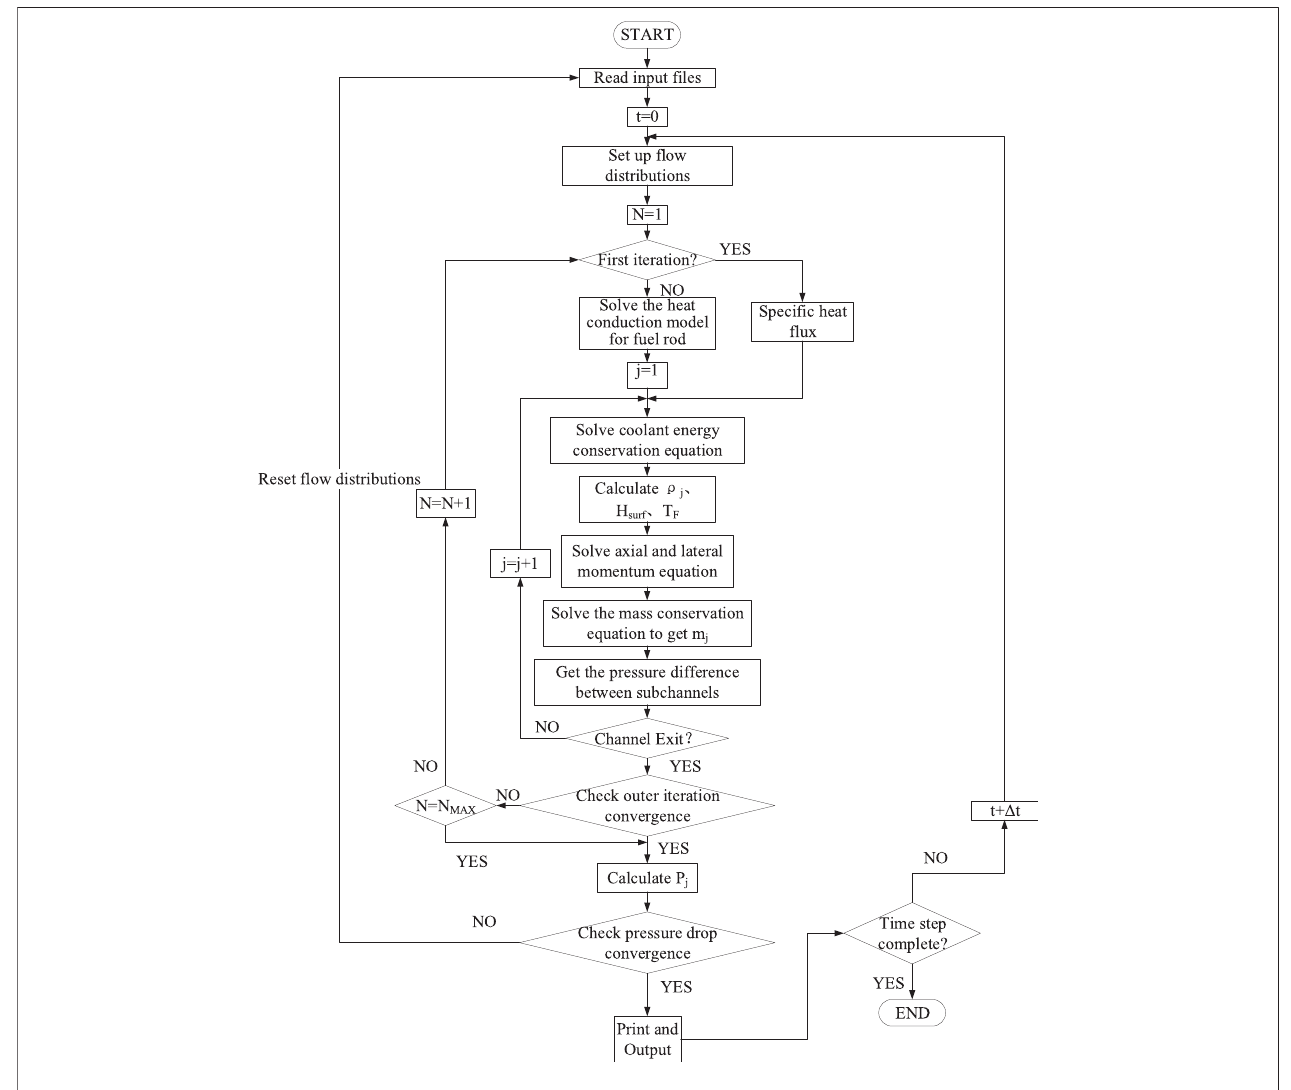
FIGURE 4 | Calculation flow-chart of